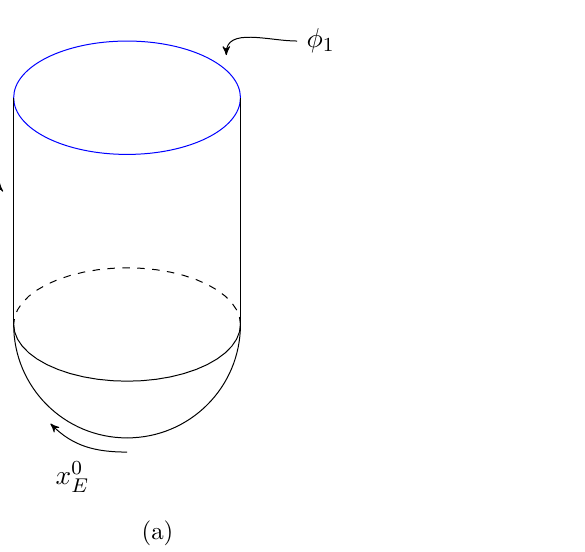
Ψ( t ) . The cap | i φ 1 σ R φ 0 h | | i